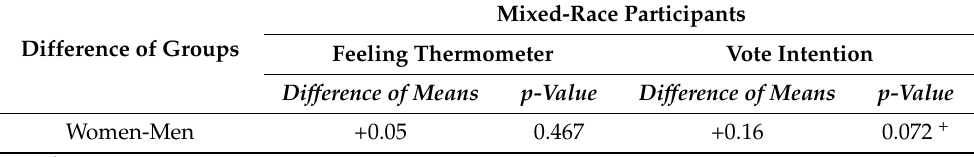
indicate that they would vote for the biracial-identified candidates than are men.